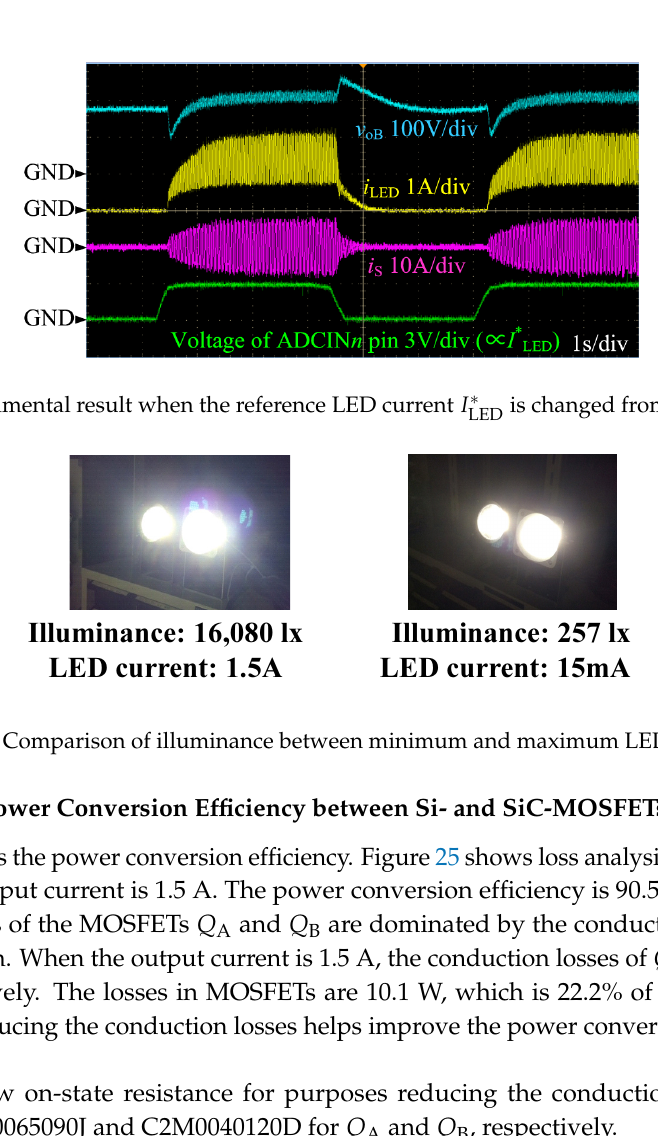
Figure 24. Comparison of illuminance between minimum and maximum LED